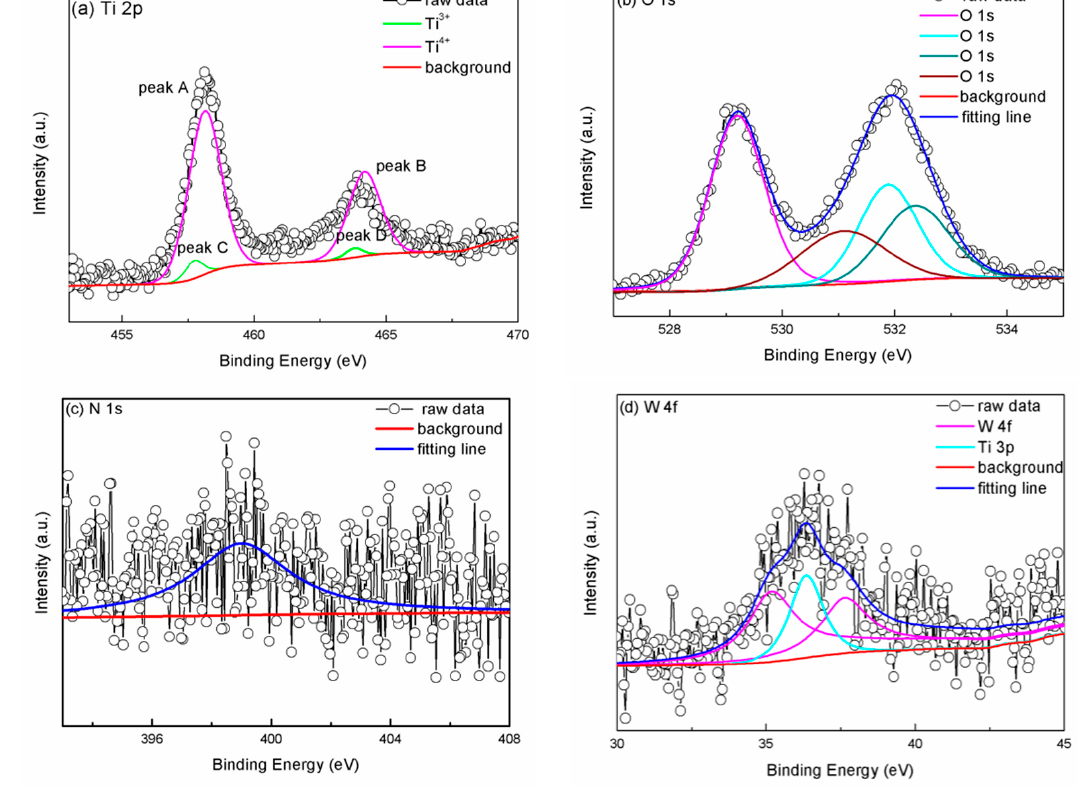
Figure 2. XPS spectra for ( a ) Ti 2p, ( b ) O 1s, ( c ) N 1s, and ( d ) W 4f core-level for sample 4, respectively.